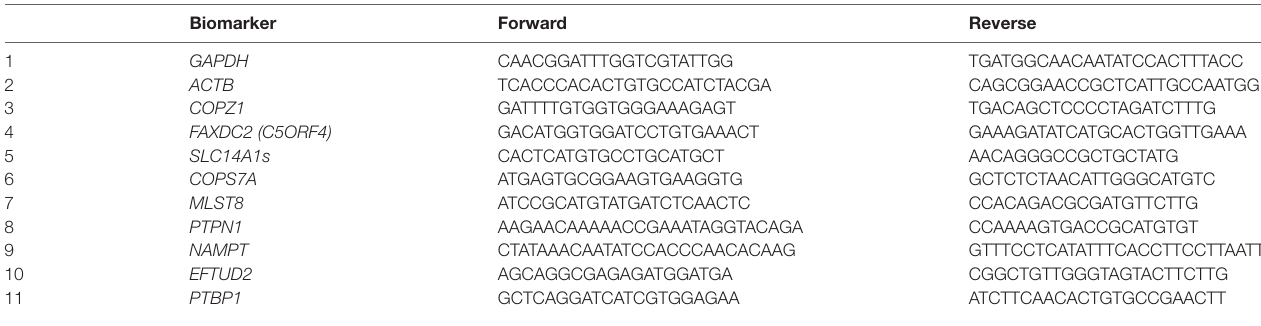
TABLE 2 | Primer sequences for the biomarkers tested in